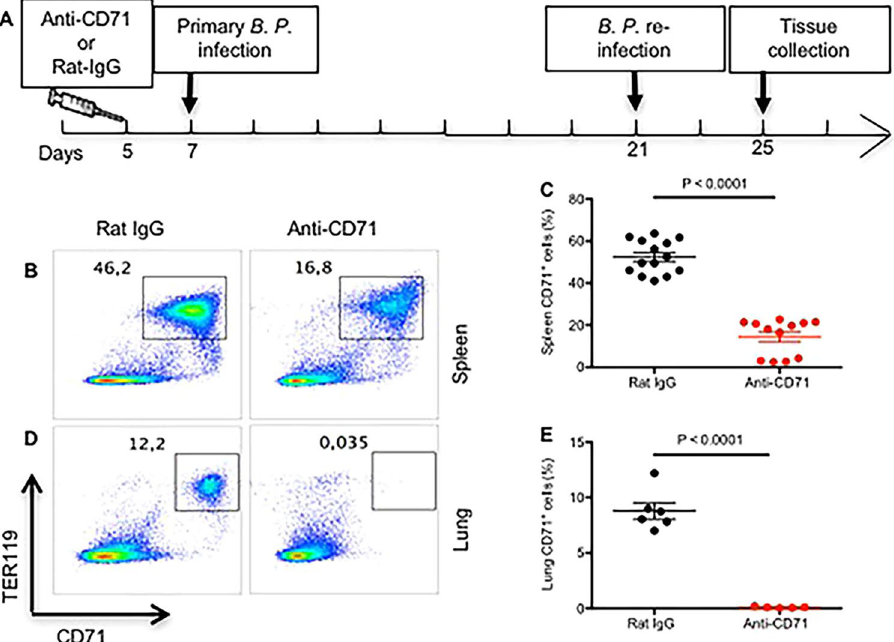
Figure 1. Anti-CD71 antibody significantly depletes CD71 + erythroid cell in the lungs and spleen on newborn mice. ( A ) The cartoon shows intervention time points. ( B,D ) Representative plots showing percent CD71 + Ter119 + in the spleen and lungs for isotype (Rat-IgG) treated compared with anti-CD71 treated mouse. ( C–E ) Percent CD71 + cells in the spleen and lungs for anti-CD71 treated versus controls, day 2 post